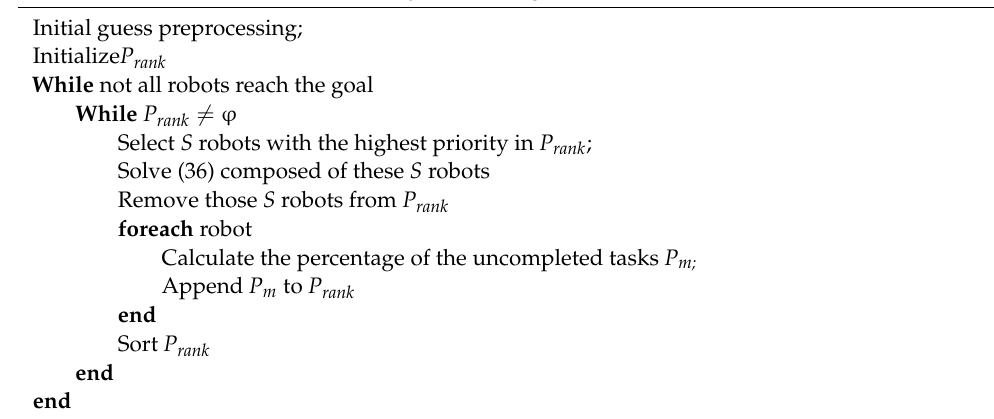
Algorithm 1 : Model Predictive Priority Contouring Control.